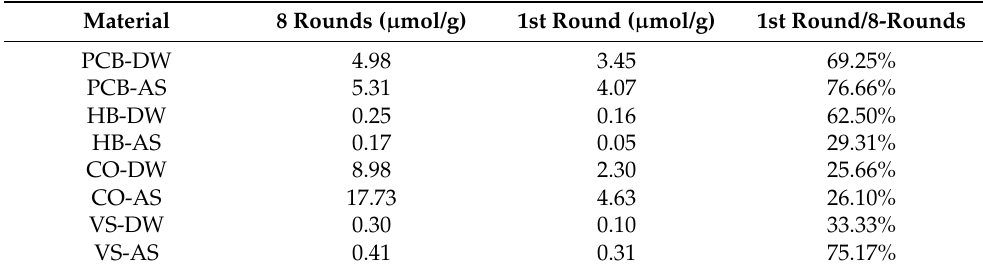
Table 2. Ammonium leaching quantities of filler materials in deionized water (DW) or artificial stormwater